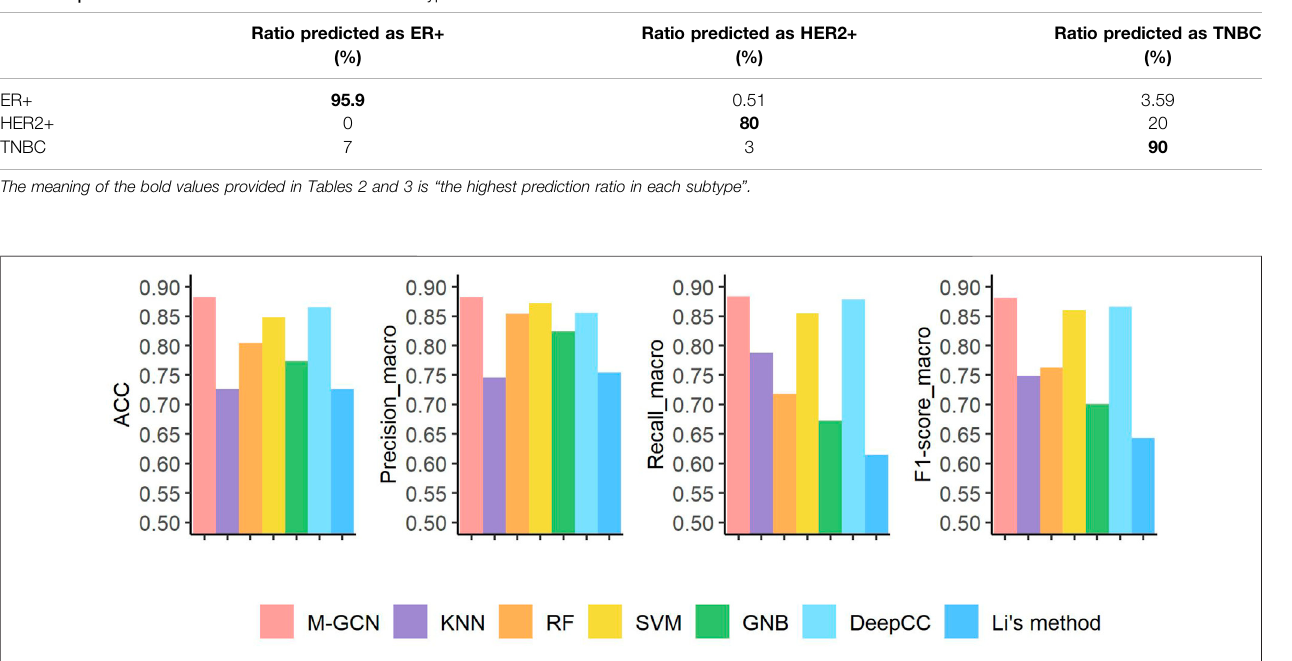
TABLE 2 | Classi fi cation results of M-GCN on each subtype of BRCA. ER+